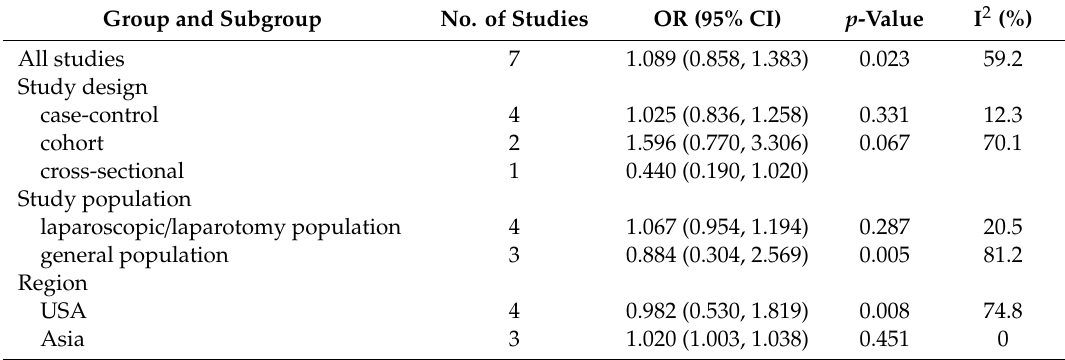
Table 4. Results of the meta-analyses of studies of the association between mono(2-ethylhexyl) phthalate (MEHP) and